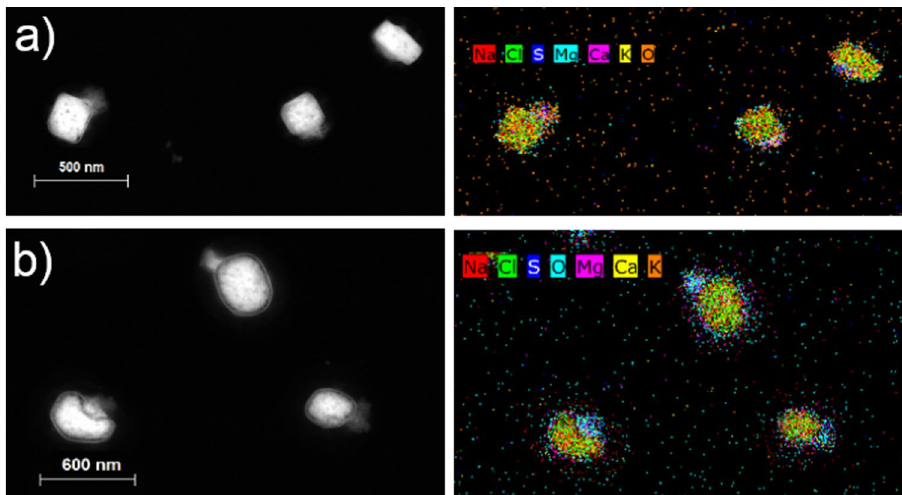
Figure 5. Effect of ageing on shape and elemental composition. Microscopy images (STEM-EDX) of fresh ( a ) and aged ( b ) sea salt particles, illustrating the shape and elemental compositions found in these